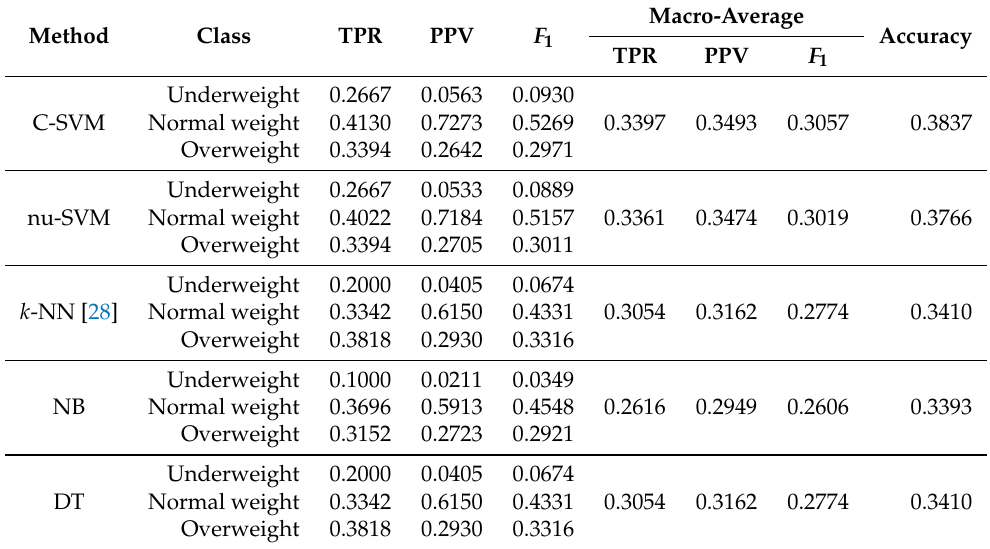
Table 10. Leave-one-person-out cross-validation results of the five benchmark methods when the undersampling technique is used.